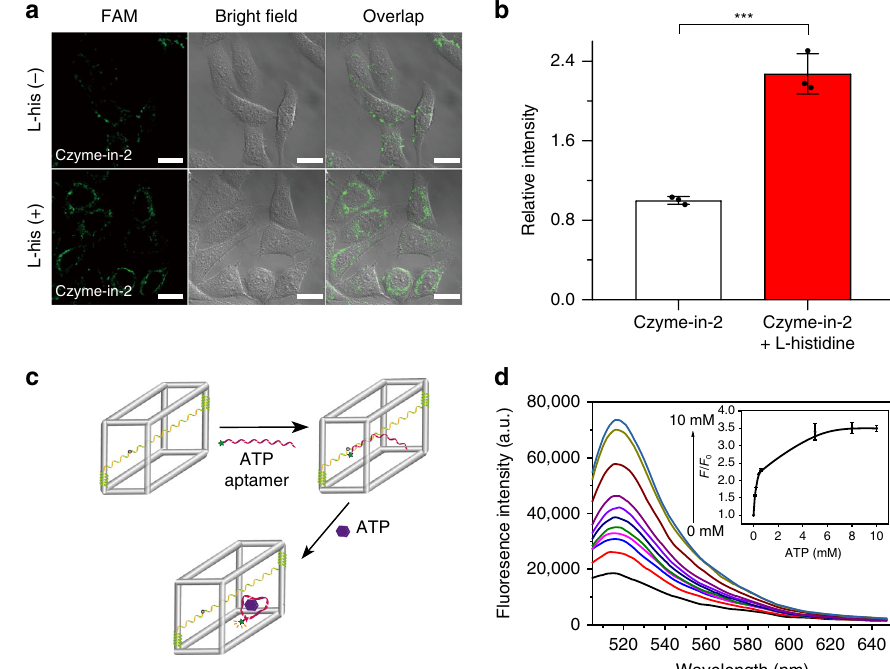
Fig. 5 The biosensing application of CONFINED-based biosensor. a Fluorescence confocal imaging of HeLa cells incubated with Czyme-in-2 without and with L -histidine, respectively. The scale bars are 20 μ m. b The relative fl uorescence intensity of Czyme-in-2 confocal imaging that quanti fi ed by ImageJ; Data are presented as mean values± s.d. ( n = 3), Student ’ s t test, *** p = 0.00043 < 0.001, by two-tailed unpaired Student ’ s t -test. c Schematic illustration of ATP aptamer encapsulated in the DNA cages (Cage-apt-in-2). d Fluorescence response in the presence of different concentrations of ATP, ranging from 0 to 10 mM. Inset: relationship between fl uorescence enhancement and concentrations, data are presented as mean values ± s.d. ( n = 3). Source data are provided as a Source Data fi